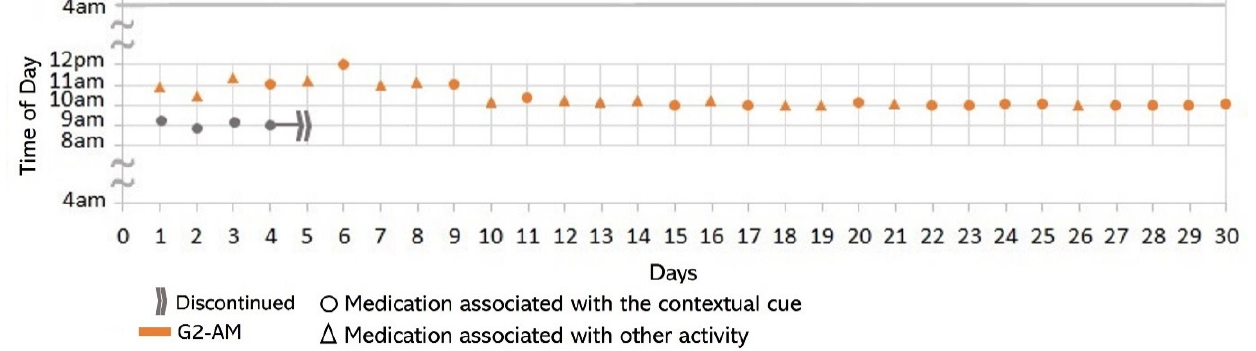
Figure 2. Locations and pill containers used by ( a ) S1, ( b ) S2, ( c ) S3, and ( d ) S4.